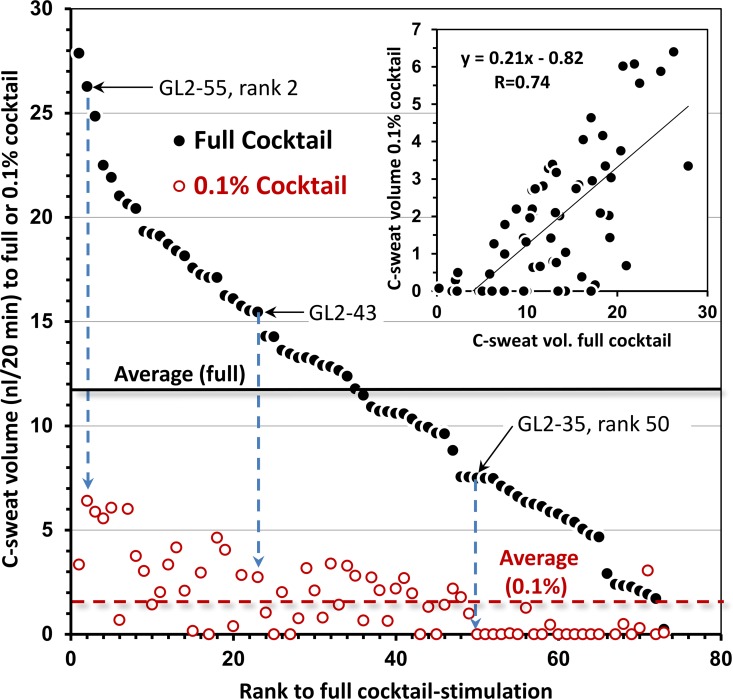
Distribution of responses to two cocktail strength for 73 identified glands at site L2 of subject EB01.Glands are rank ordered by the volume of their C-sweat in response to full cocktail (filled circles), and the corresponding response of each glands to the 0.1% b-adrenergic cocktail is shown directly below (open circles). Each pair of points represents the mean total volumes secreted during 20 min across 1–3 trials at the two cocktail strengths. (Three selected pairs of responses are connected by vertical arrows and are labeled by gland ID and rank based on response to full cocktail.) The solid horizontal line is the mean response to full cocktail and the dashed horizontal line is the mean response to 0.1% cocktail. The average coefficient of variation for individual gland responses was 0.36 to the full cocktail and 0.90 for 50 of 73 glands that responded to the 0.1% cocktail on at least one trial. Inset plots correlation of the two responses; R = .74, P <0.001.